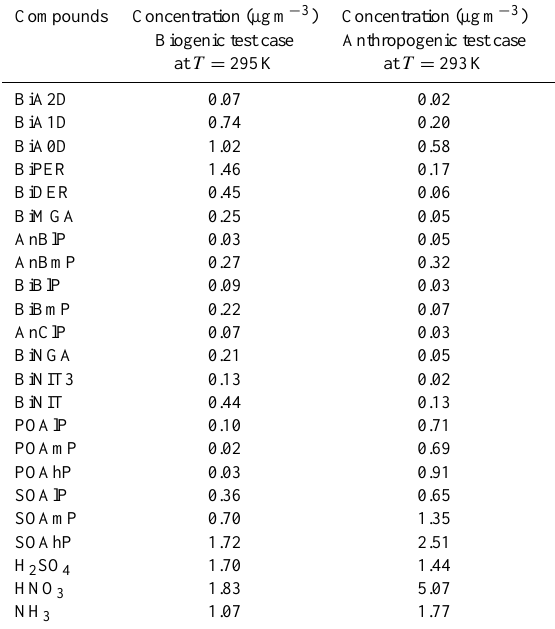
Table 5. Conditions of the test